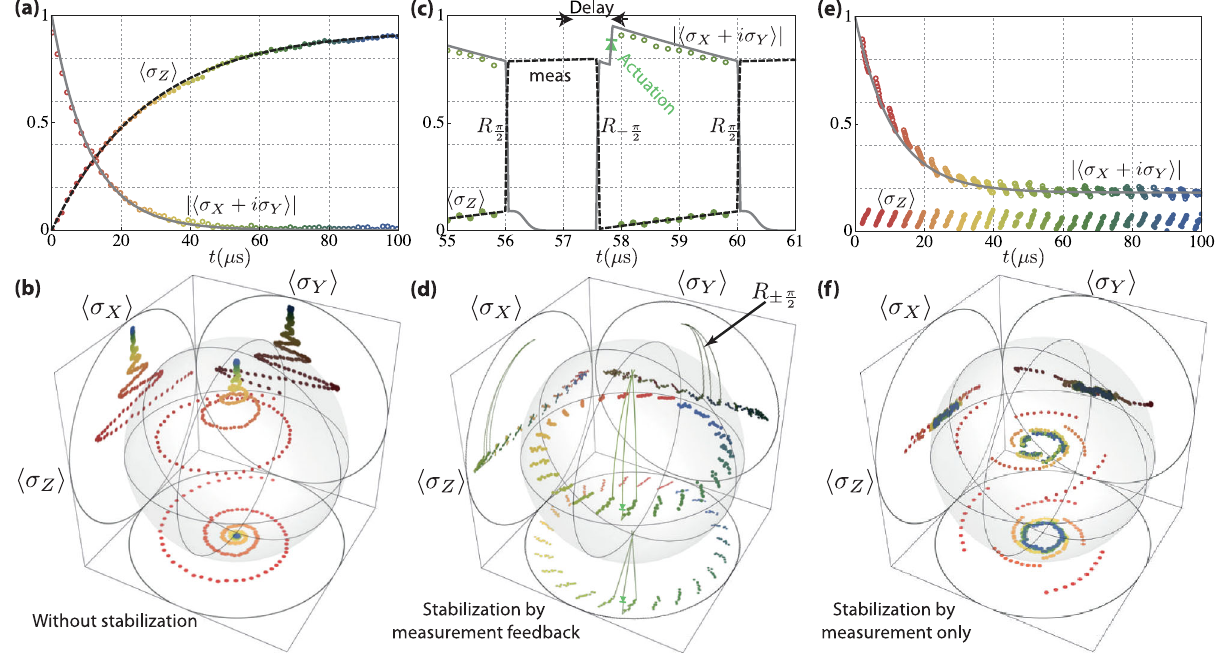
i (filled dots) and of the coherence jh (cid:10) þ i(cid:10) ij (open circles) when the qubit is prepared in state FIG. 2. (a) Evolution of h (cid:10) ffiffiffi p Z X Y ðj g i þ j e iÞ = 2 at time 0 . The color encodes the time identically in all panels. The lines are exponential fits that use coherence time ¼ 11 : 5 (cid:1) s and relaxation time T ¼ 28 (cid:1) s . (b) Same evolution represented in the Bloch sphere with a Ramsey frequency T 2 1 = 2 (cid:2) ¼ 100 kHz . At each time (color), the outcome of qubit tomography is represented as a filled dot in the Bloch sphere and ! Ry in the three orthogonal projection planes. The large open black circles set the scale of the Bloch sphere extrema. (c) Same evolution as in (a), with stroboscopic measurement feedback every 4 (cid:1) s . State tomography is only performed outside of the sensing and actuation periods. The lines represent the results of a simulation without extra fit parameters. When the conditional (cid:2) pulse occurs (actuation), the average purity increases so that the coherences are permanently preserved, on average. (d) Same = 2 (cid:2) ¼ 10 kHz , instead of 100 kHz for a clearer evolution represented in the Bloch sphere with a Ramsey frequency ! Ry observation of the trajectory. The simulated trajectory is represented as a line only for the time interval chosen in (c) for clarity. as in (a), (e) Evolution of the qubit with the same process as in (c),(d) but without actuation. The exponential fit, using the same T 2 indicates an average persistent coherence of 18% without any actuation. (f) In the Bloch sphere, the Ramsey frequency is chosen = 2 (cid:2) ¼ 100 kHz to be ! Ry